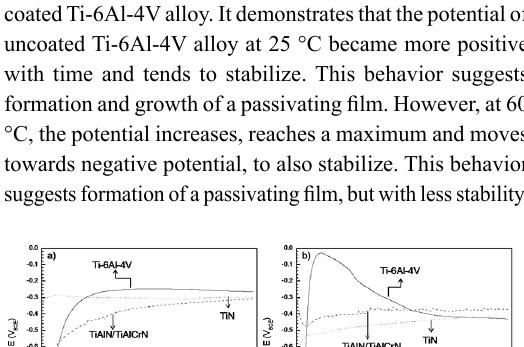
were not ground in order to maintain the coating integrity.